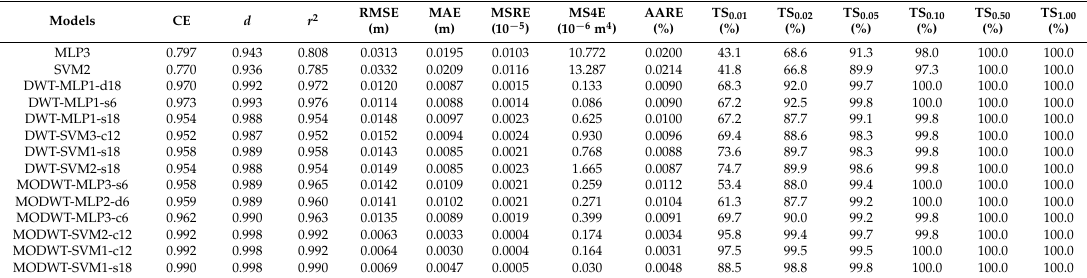
Table 3. Comparison of higher performance models for the low